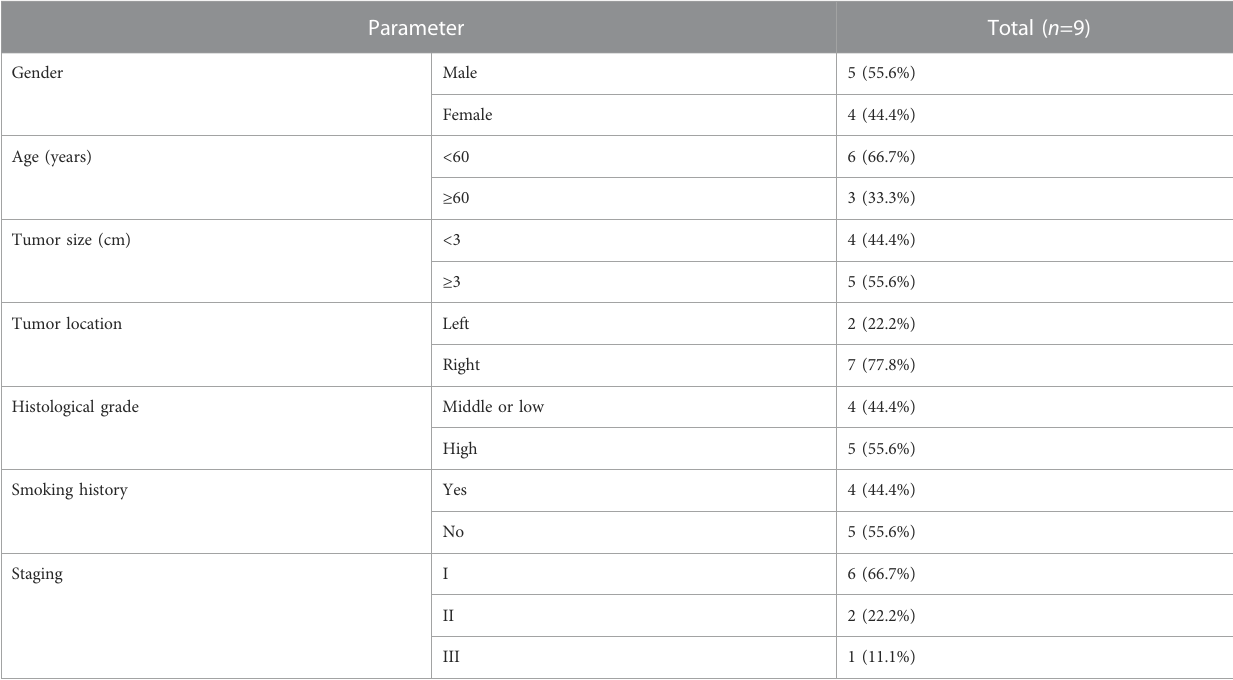
TABLE 2 | Clinicopathologic characteristics of 9 LUAD